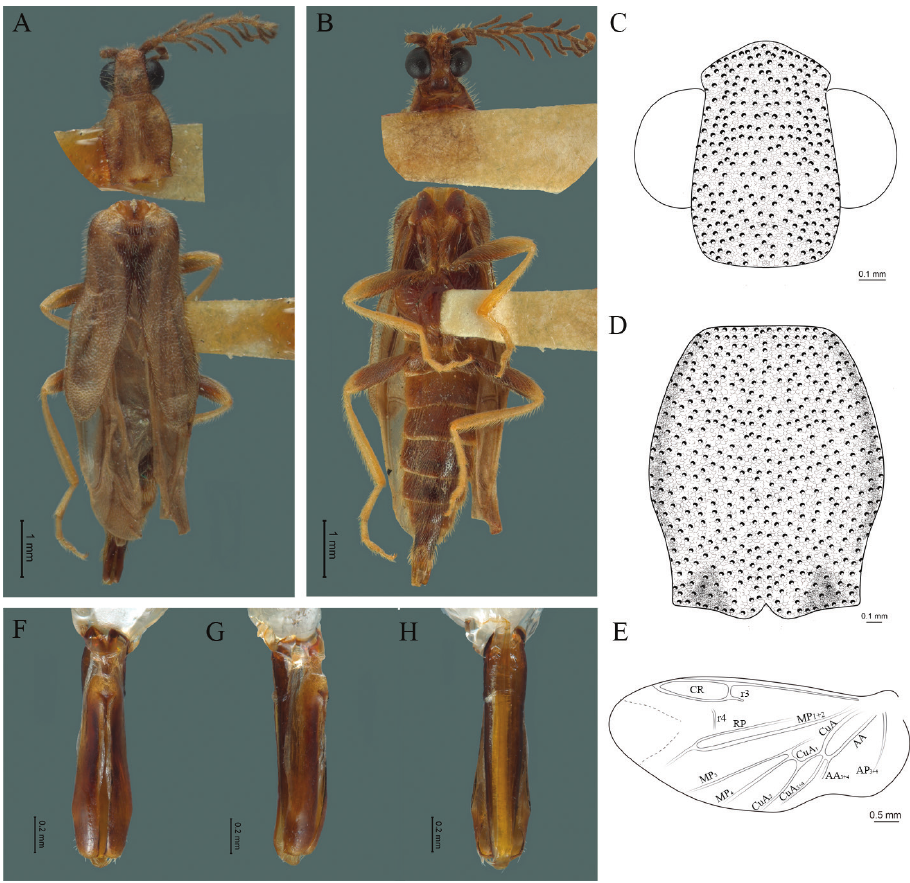
Figure 17. Cenophengus marmoratus Wittmer, 1976, male. Habitus: A dorsal B ventral C head dorsal D pronotum dorsal E hind wing. Wing venation: CR = Radial Cell; r3 = radial 3 vein; r4 = radial 4 vein; RP = Posterior Radial vein; MP1+2 = Posterior Median vein; CuA = Cubital vein; AA and AP = Anterior and Posterior Anal veins. Aedeagus: F dorsal view G lateral view H ventral than respective antennomere, pronotum mottled with darker brown spots (Fig. 17A, B).